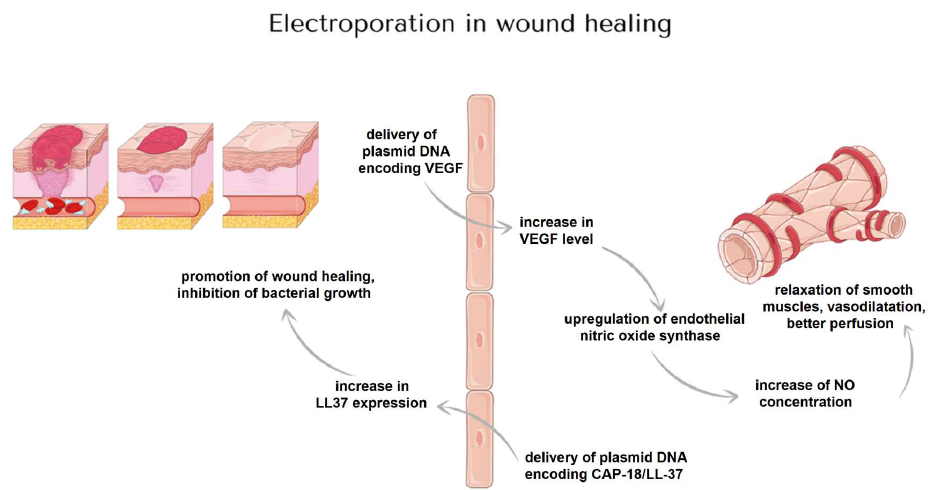
Figure 5. Schematic visualization of combinations used in immunogen electrotransfer, considering Il-12 and its combinations with other techniques, as well as Il-15 and Il-28